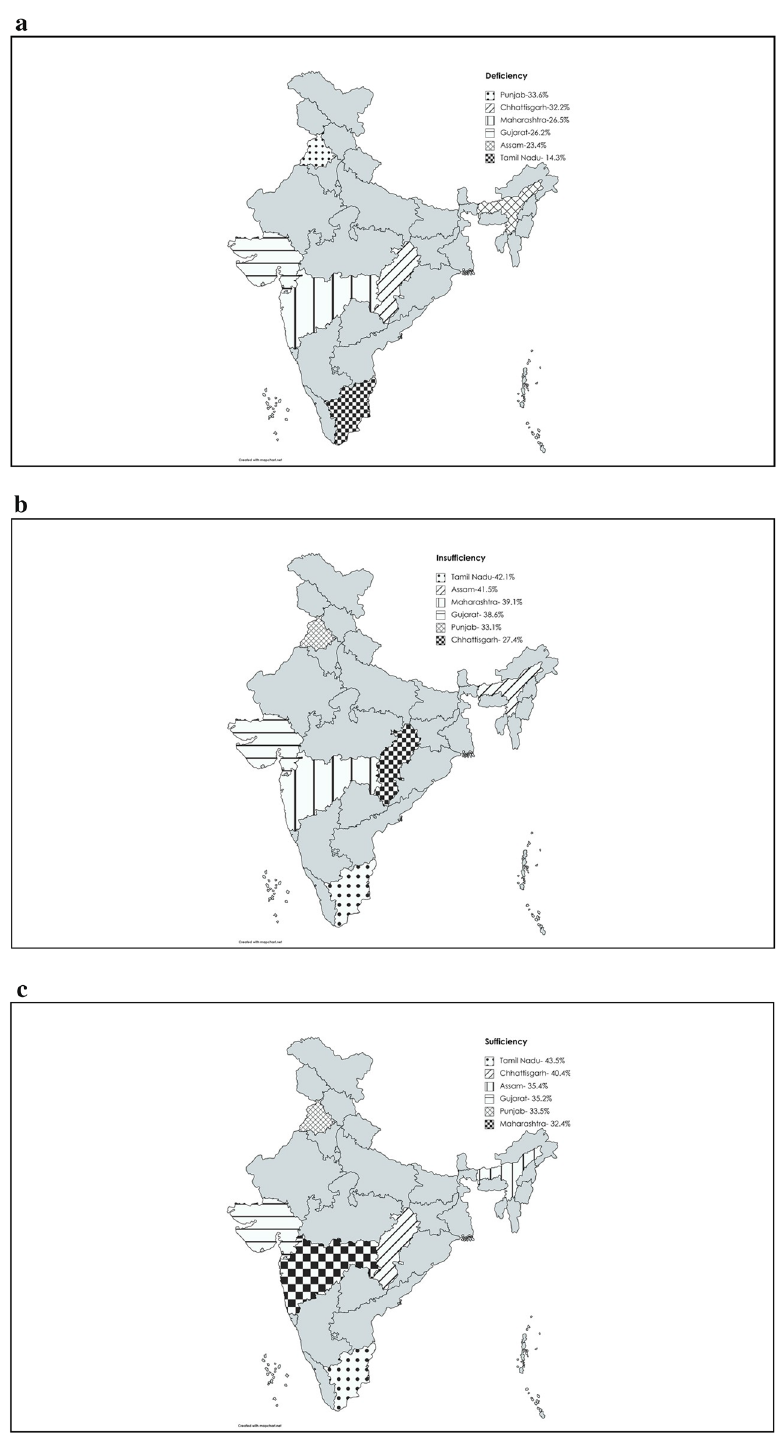
Figure 4. ( a – c ) Indian state wise prevalence of vitamin D-deficiency, insufficiency and sufficiency. (Created with mapchart.net (https:// www. mapch art. net/ india.